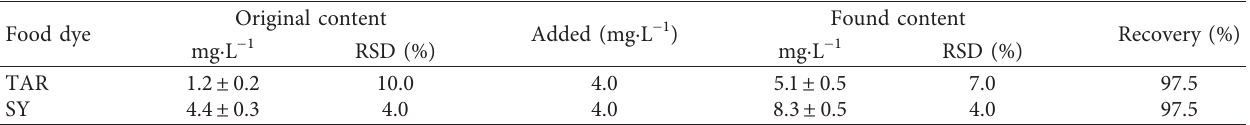
Table 2: Results for the determination of dyes in the beverage “Festival” ( n � 3, P � 0 . 95). Food